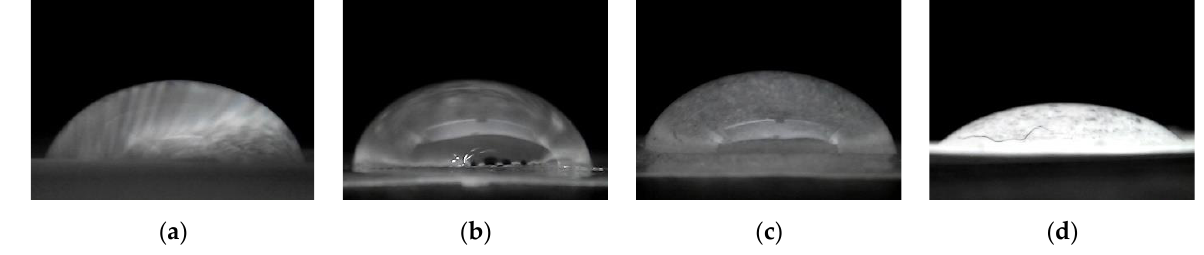
Figure 6. Elastic modulus of the cellulose bioplastic samples at various ECH concentrations.